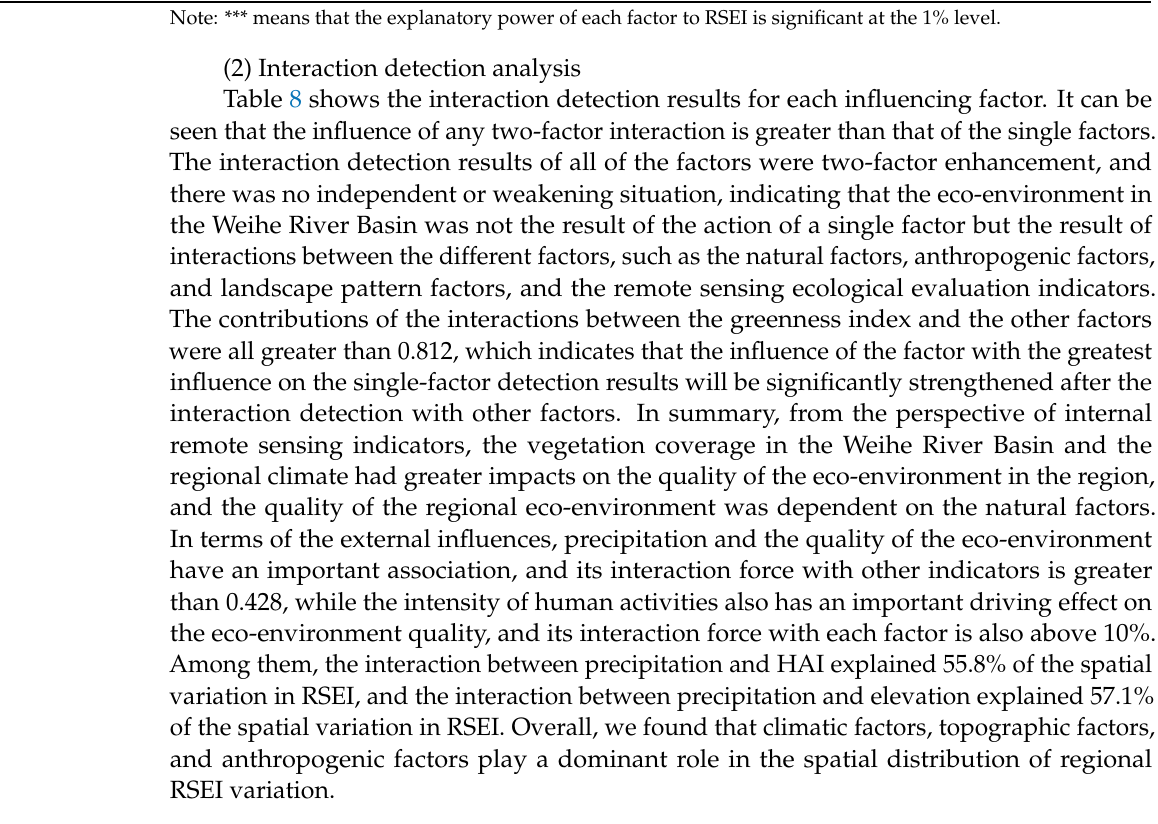
Table 8. Interaction detection results for each influencing